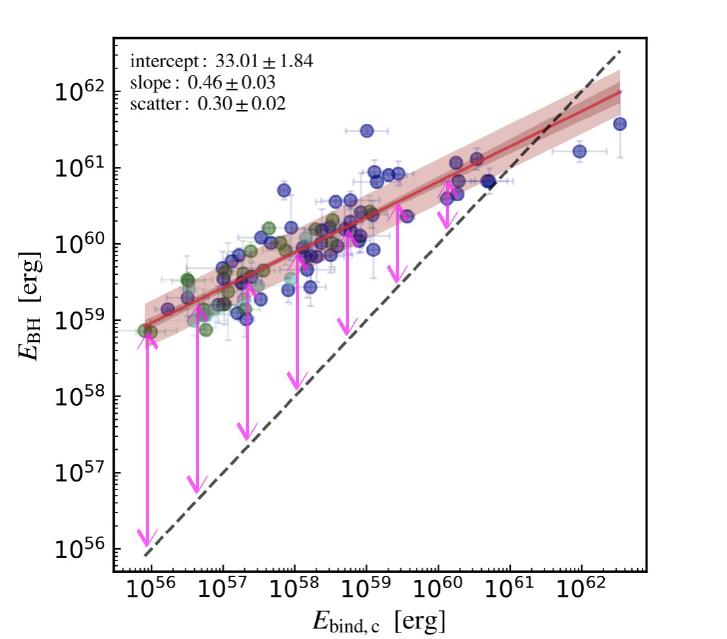
Figure 12. Available mechanical feedback energy of the central SMBH versus gravitational bind- ing energy of the hot gas within the core of the host halo ( R (cid:46) 0.15 R 500 ). The SMBH energy is E BH = 10 − 3 M BH c 2 , while the binding energy is related to the thermal energy via the virial theorem E bind ≈ 2 E th ∝ M gas T x . The 85 points are taken from Gaspari et al. [77], which include the observed direct/dynamical SMBH mass with the X-ray halo detected in the host group or cluster. The solid red curve shows a fit to the relation with a power law, with the 16–84 percentile interval being indicated by the red shaded area. The 1- σ intrinsic scatter is plotted as a light red band on top of the mean fit. The circle colors reflect the morphological type of the central galaxy: elliptical (blue), lenticular (green), and spiral (cyan). The black dashed line demarks the one-to-one energy equivalence, whereas the magenta arrows highlight the excess BH energy when compared to the binding